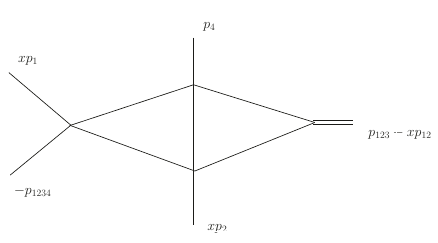
Figure 3 . The two-loop diagram representing the decoupling basis